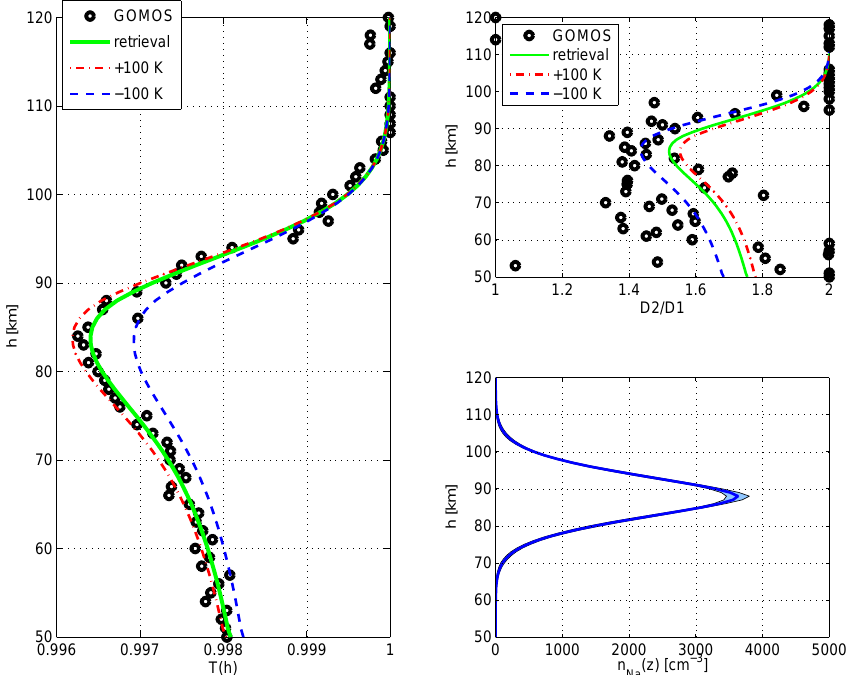
Fig. 6. Inversion of the measured effective transmittance profile for January 2003 in the latitudinal bin 70 ◦ N–80 ◦ N. Left side: effective transmittance versus tangent height; circles: measured values; green full line: best modeled value; red and blue lines: same conditions as for green line but with +100K (respectively − 100K) added to the used climatological temperature profile. Right side: top: D 2 /D 1 ratio for the same case; bottom: retrieved Na vertical profile with its error bar envelope.